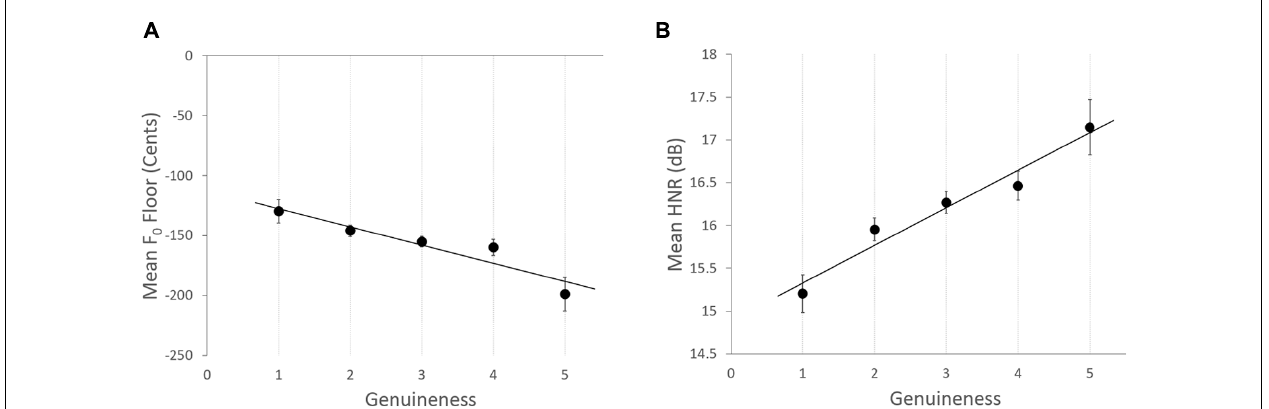
FIGURE 4 | Relationships between vocalists’ acoustic features and in Experiment 2 for (A) Mean F 0 floor for each genuineness rating category. Solid black line indicates a line of best fit, with a linear regression solution: F 0 floor = − 112.49 − 15.21 × Genuineness. (B) Mean HNR for